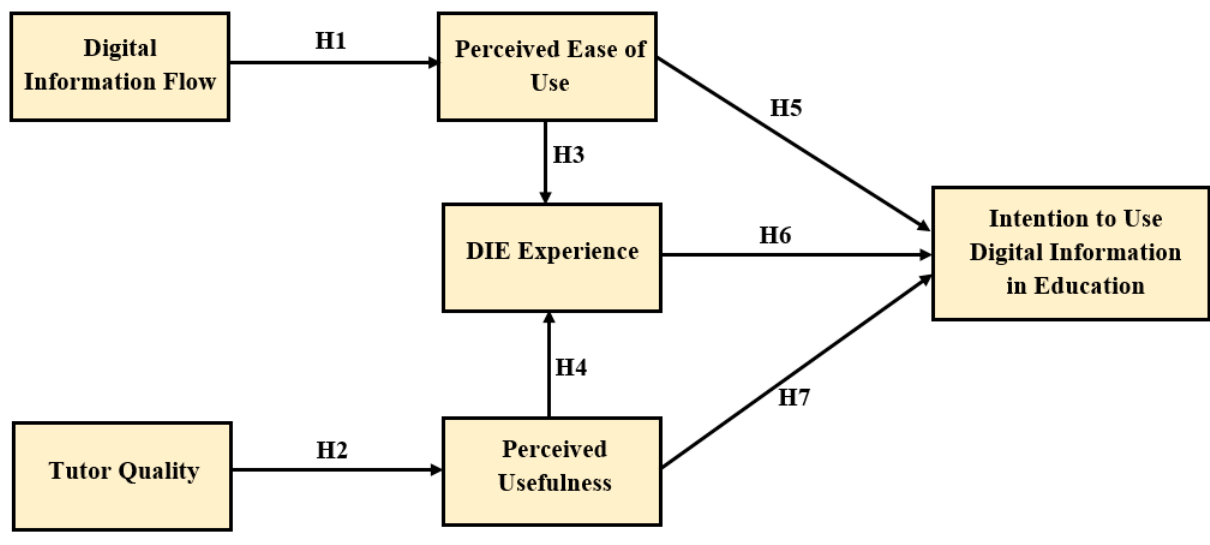
Figure 1. Research Figure 1. Research model.